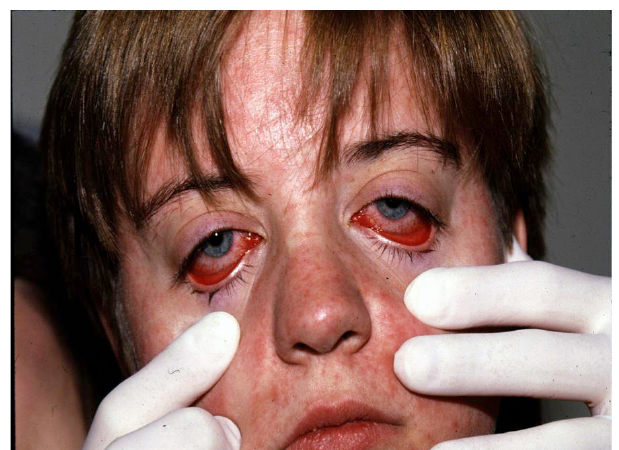
Figure 1. Nonpurulent conjunctivitis and facial rash of measles one day after rash began. Photo used with permission of Michael J. Burns, MD.